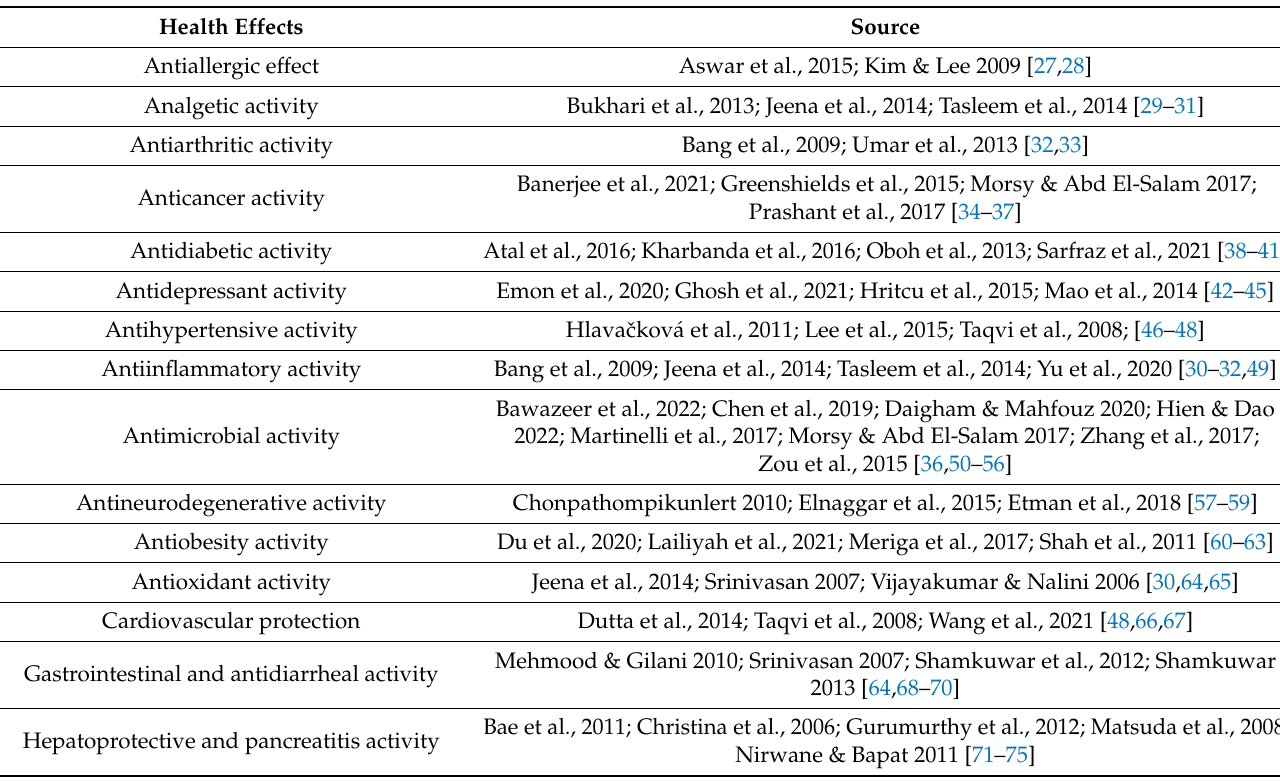
Figure 2. Health properties of black pepper and piperine. Source: own study . Table 1. Health properties of black pepper and piperine based on other authors’ studies.